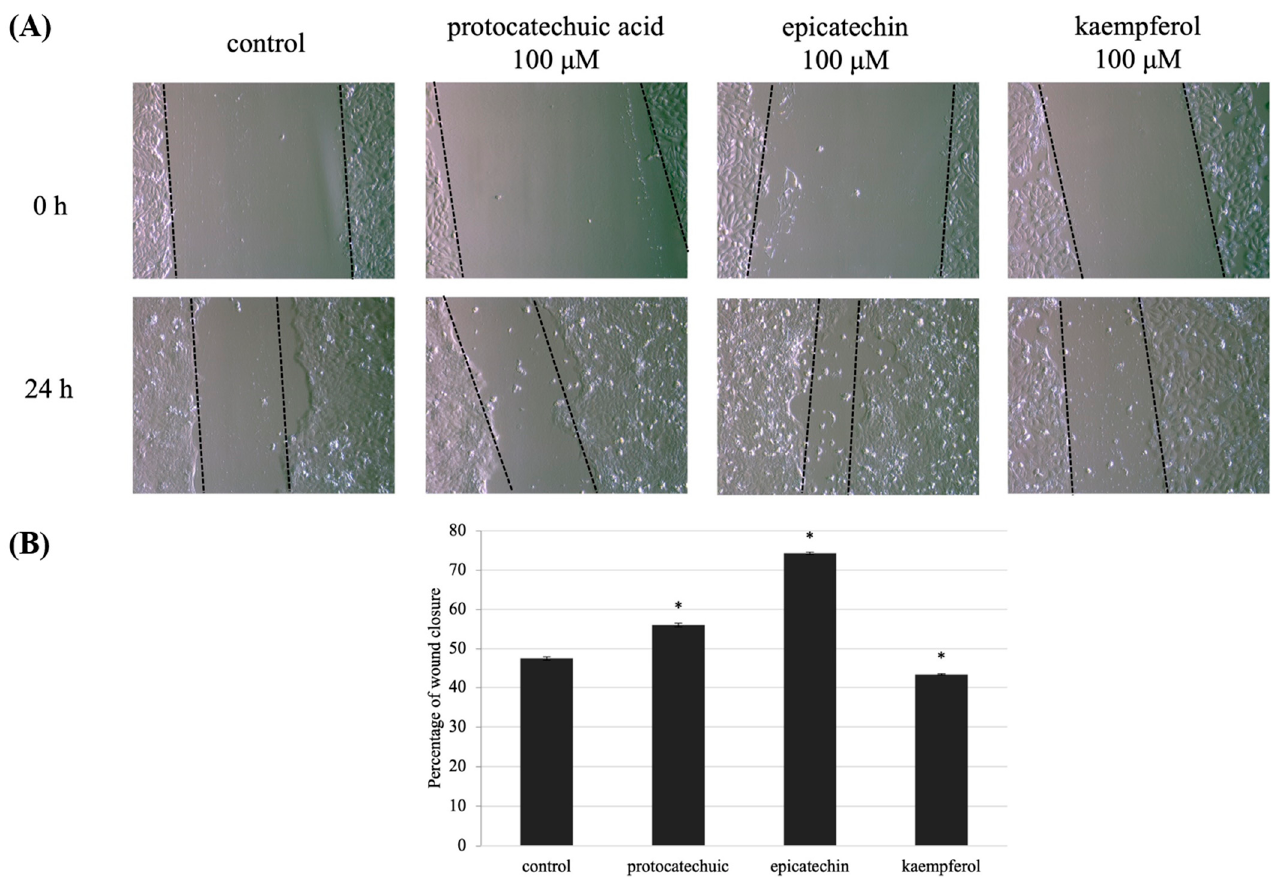
Figure 7. UVB-induced defect in HaCaT cells migration is decreased by protocatechuic acid ( 2 ), epicatechin ( 4 ), and kaempferol ( 11 ) pre-treatment. ( A ) Wound areas were formed in confluent layers of untreated and treated HaCaT cells prior to UVB irradiation. Phase-contrast images of the wounds were captured 0 and 24 h following irradiation. ( B ) The percentage of cell migration indicates the wound area at 0 and 24 h after making wound area and UVB-induced, compared with the initial area at 0 h. Values are presented as the mean ± SD of three wells.; * p < 0.01 compared with the control